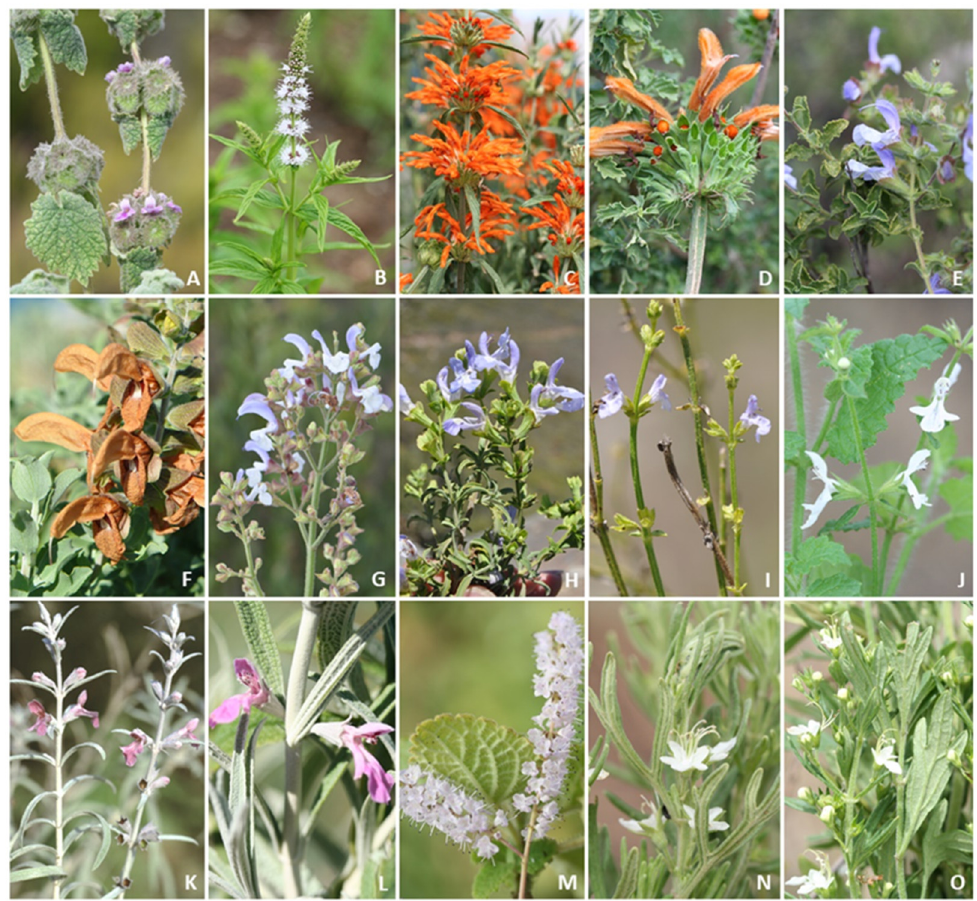
Figure 1. Southern African medicinal plants of the Lamiaceae that are commonly used in tradi- tional medicine: ( A ) Pseudodictamnus africanus ; ( B ) Mentha longifolia ; ( C ) Leonotis leonurus ; ( D ) L. ocymifolia ; ( E ) Salvia africana ; ( F ) S. aurea ; ( G ) S. chamealaeagnea ; ( H ) S. dentata ; ( I ) S. stenophylla ; ( J ) Stachys aethiopica ; ( K ) S. linearis ; ( L ) S. rugosa ; ( M ) Tetradenia riparia ; ( N ) Teucrium africanum and ( O ) T. trifidum . All photographs taken by B.-E. Van Wyk.